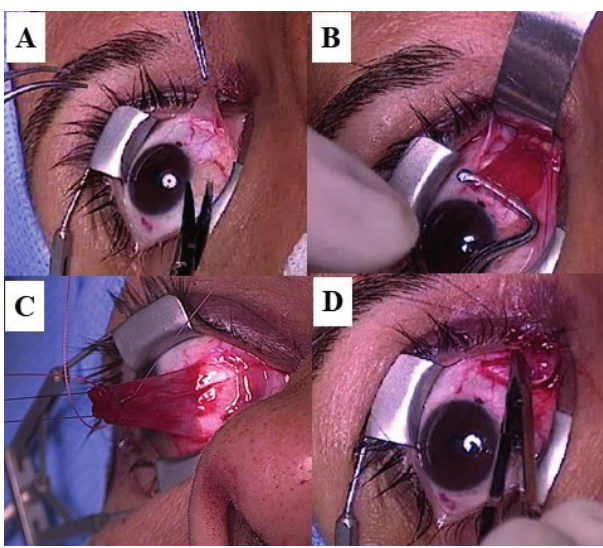
Figure 2. Ophthalmologic approach of the right eye. A. Transconjunctival incision; B. Isolation of the MRM with a muscle hook; C. Placement of a single suture on the posterior end of the distal stump. D. Introduction of the distal stump with the suture line and needle in the nasal cavity through the periorbital space.